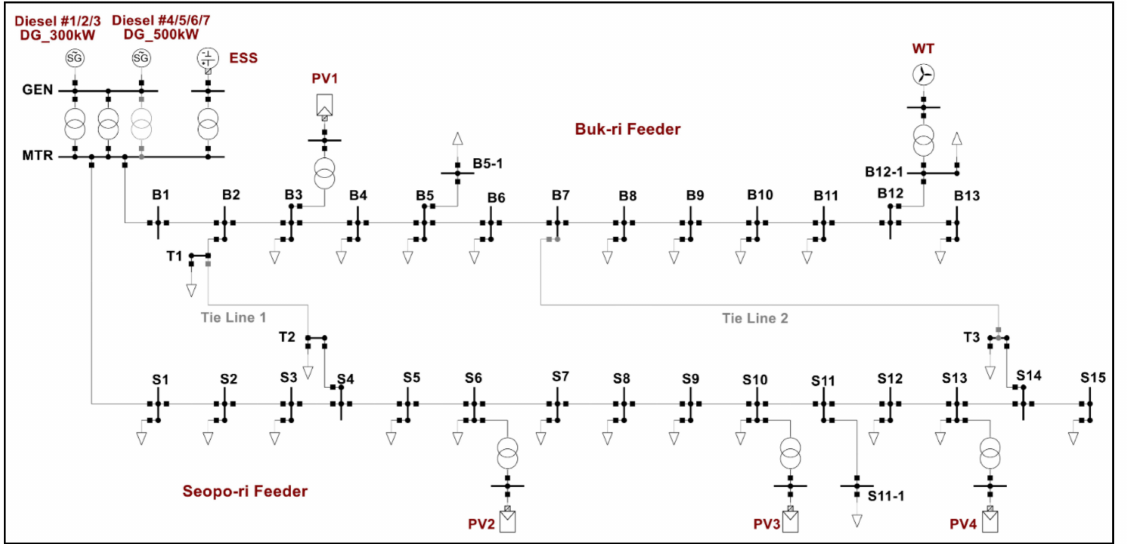
Figure 8. Deokjeok Island microgrid modeling in